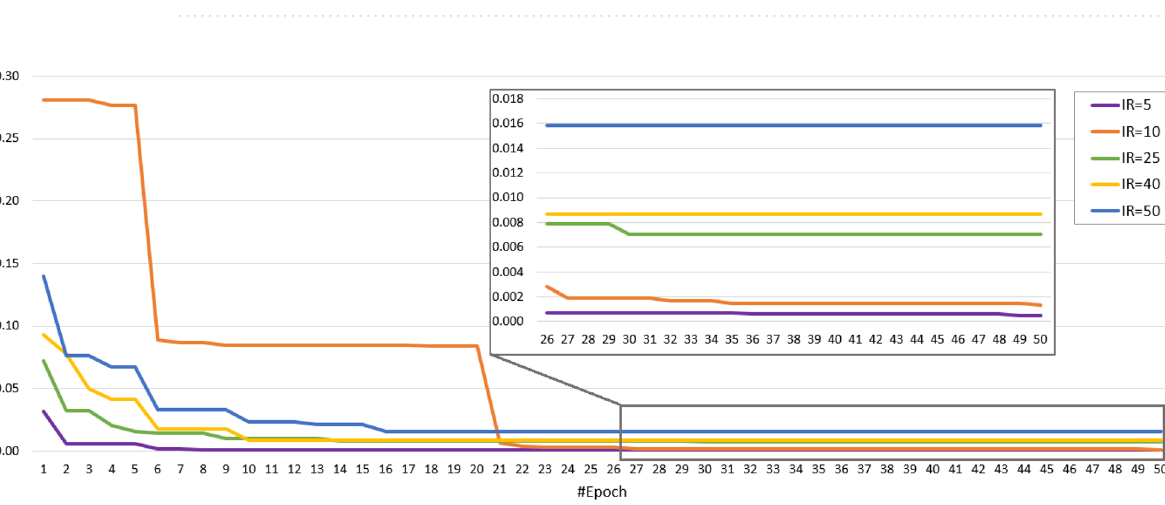
Table 2. Performance evaluation (%) of our developed deep networks on the HUST dataset in various imbalanced conditions The highest accuracy is shown in bold.